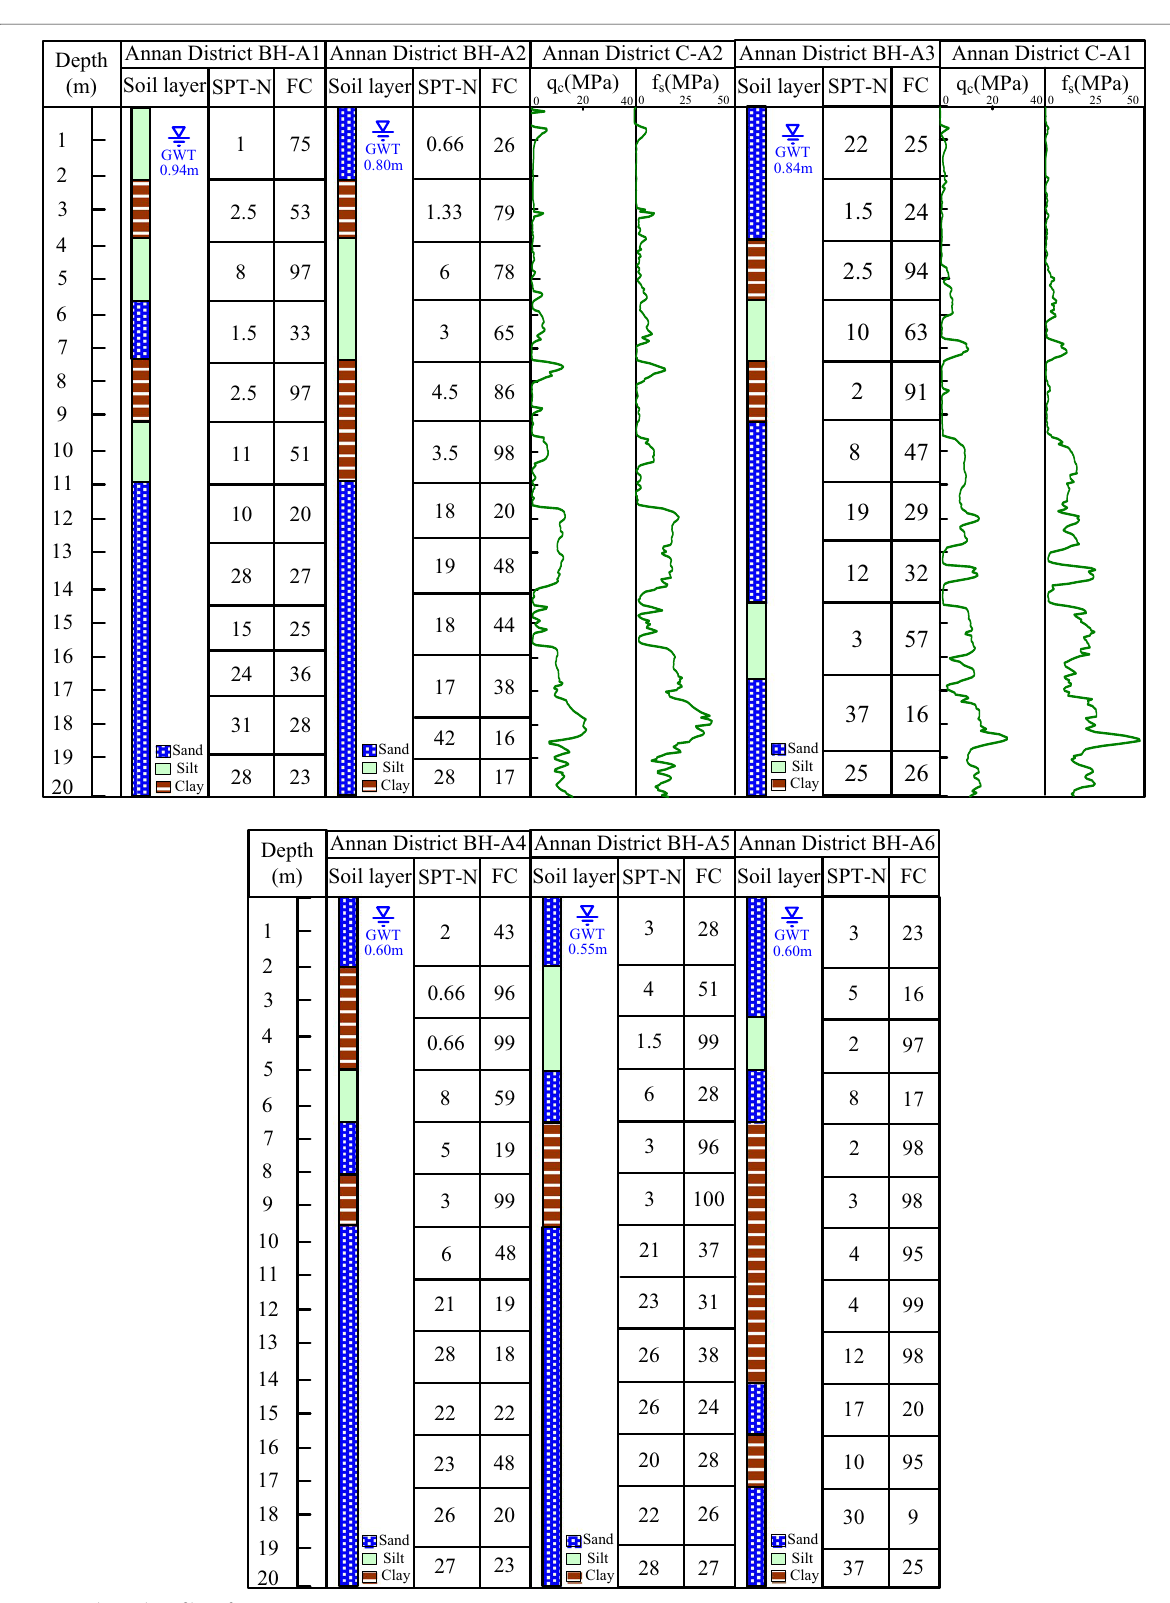
Fig. 5 Geological profiles of Annan